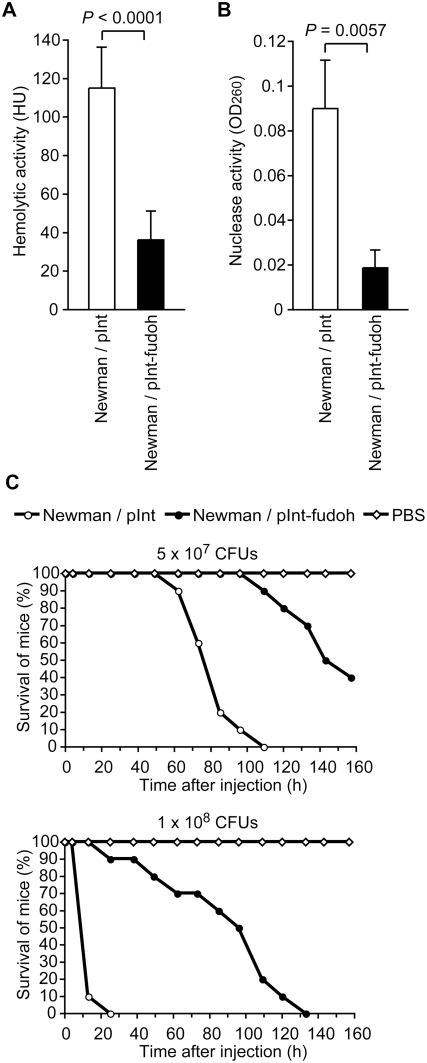
The fudoh gene decreases S. aureus exotoxin production and virulence in mice.(A) Hemolytic activities of culture supernatants of the Newman strains transformed with pInt or pInt-fudoh were measured using sheep erythrocytes. The data are means±standard deviations from three independent experiments. (B) Nuclease activities were measured using salmon sperm DNA. (C) CD-1 mice (n = 10) were injected intravenously with a diluted bacterial solution of Newman/pInt or Newman/pInt-fudoh. Statistical analysis was performed with the Kaplan-Meier test. The P-value between pInt and pInt-fudoh is less than 0.0001.